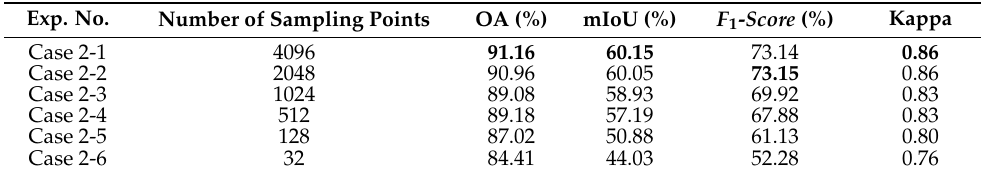
Table 6. Poind cloud classification results with different numbers of sampling points (N) under three test areas (11–13).